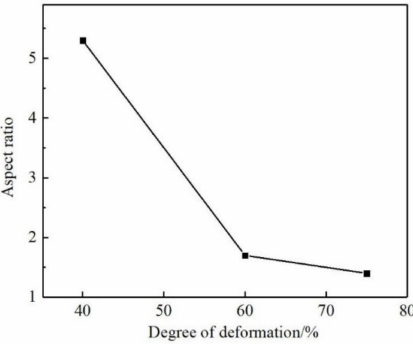
Figure 5. Aspect ratios of cementite at different deformation strains.